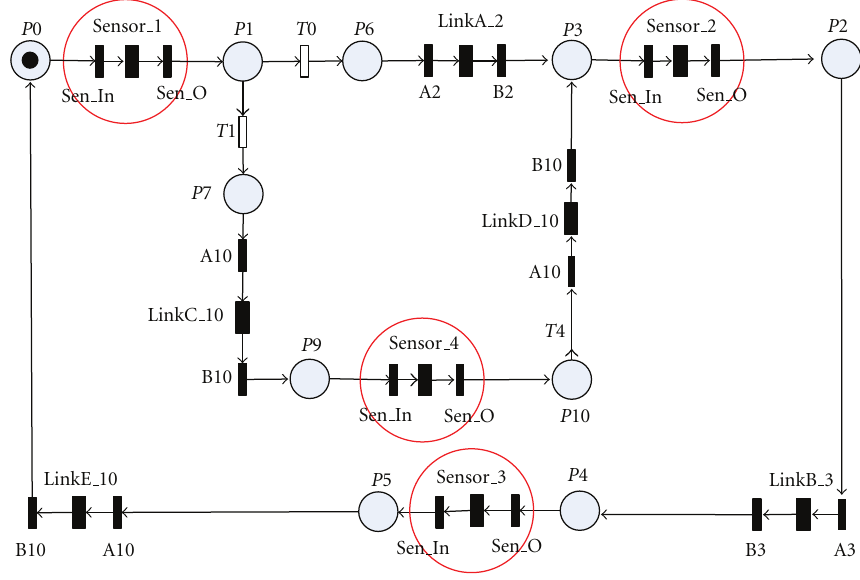
Figure 22: Petri net of wireless sensor network.